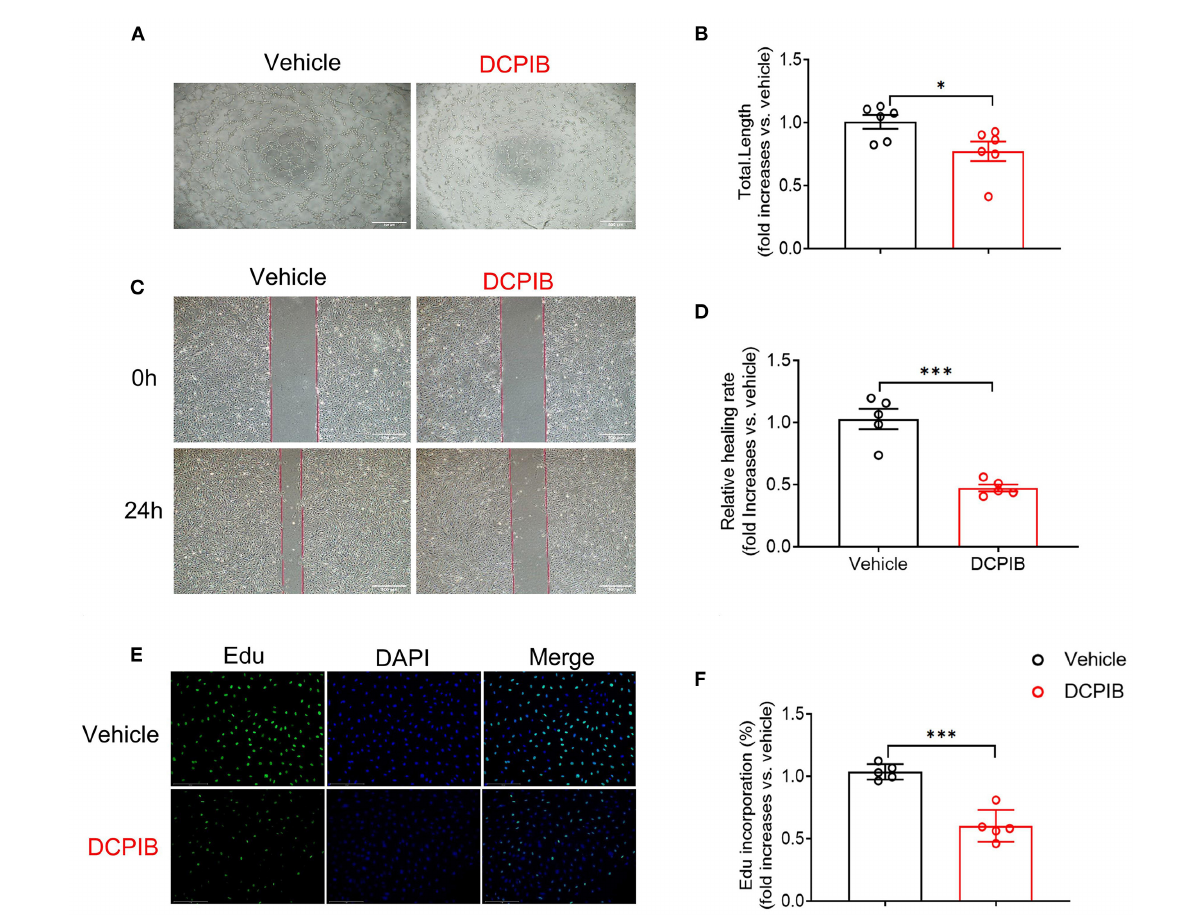
FIGURE3 DCPIB inhibited angiogenesis in vitro . (A,B) Images and quantitative results of spontaneous tube formation of HUVECs with or without 20 µ M DCPIB ( n = 6). Scale bar = 500 µ m. (C,D) Images and quantification of HUVECs wound healing assays in the presence or absence of DCPIB ( n = 5). Scale bar = 500 µ m. (E,F) Images and quantitation of proliferative ability of HUVECs with or without DCPIB evaluated by Edu staining ( n = 5). Edu (green), DAPI (blue). Scale bar = 100 µ m. * p < 0.05, *** p <